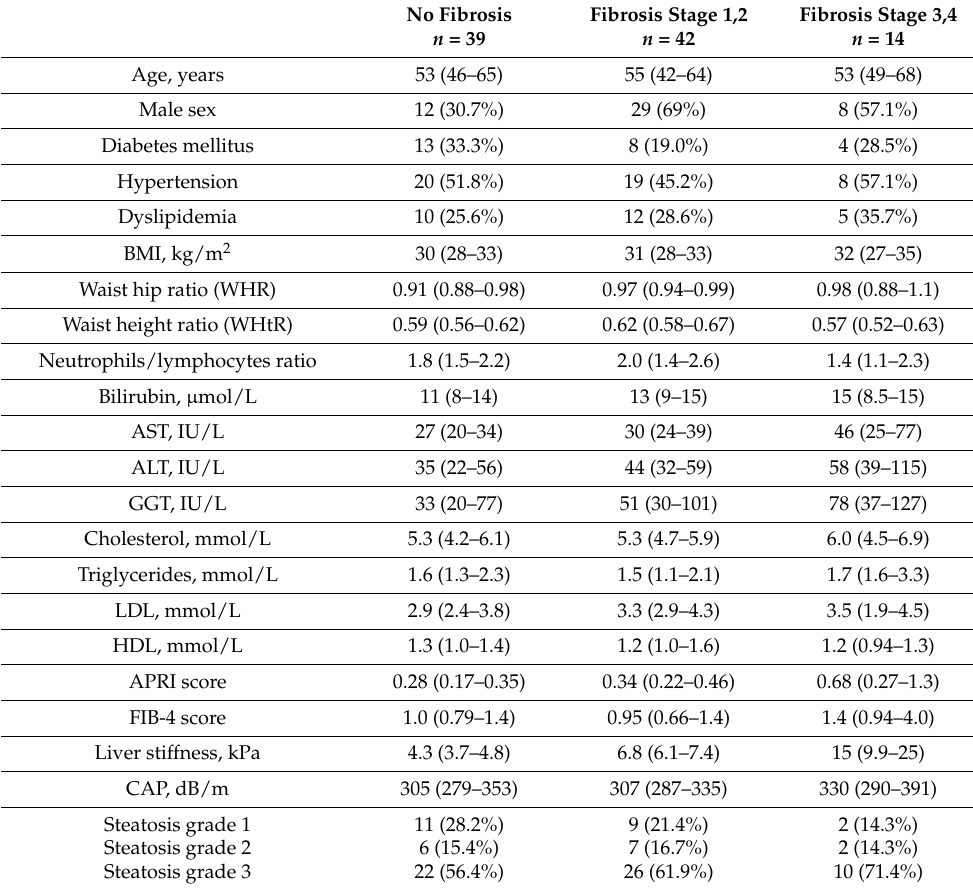
Table 1. Baseline patient characteristics according to steatosis and fibrosis